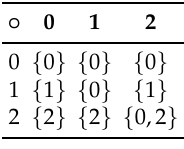
Table 2. Cayley table for the binary operation “ ∗